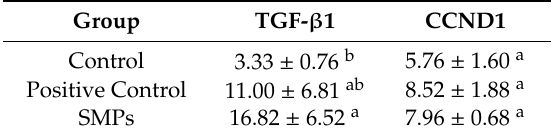
Table 5. Effect of SMPs on the growth factors of two kinds of growth factors on the 7th day ( mean ± S.D., ng/mL prot ).